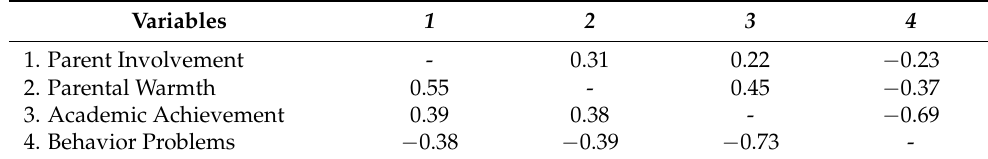
Table 2. Simple Correlations between Variables for Boys and Girls.